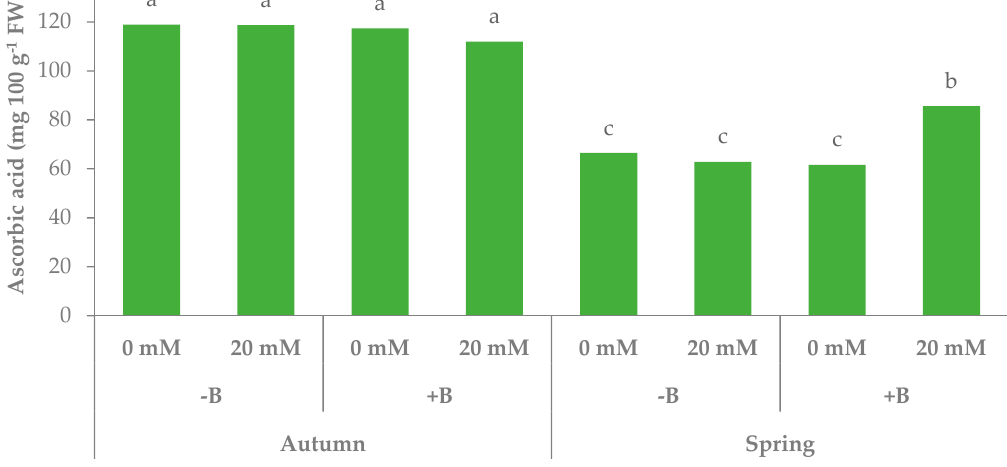
Figure 9. Ascorbic acid content of the leaf of lettuce plants grown during autumn and spring in nutrient solutions containing different levels of NaCl and with (+B) or without (-B) bacterial biostimulant (bars with different letters are significantly different at p < 0.05, according to the LSD test).